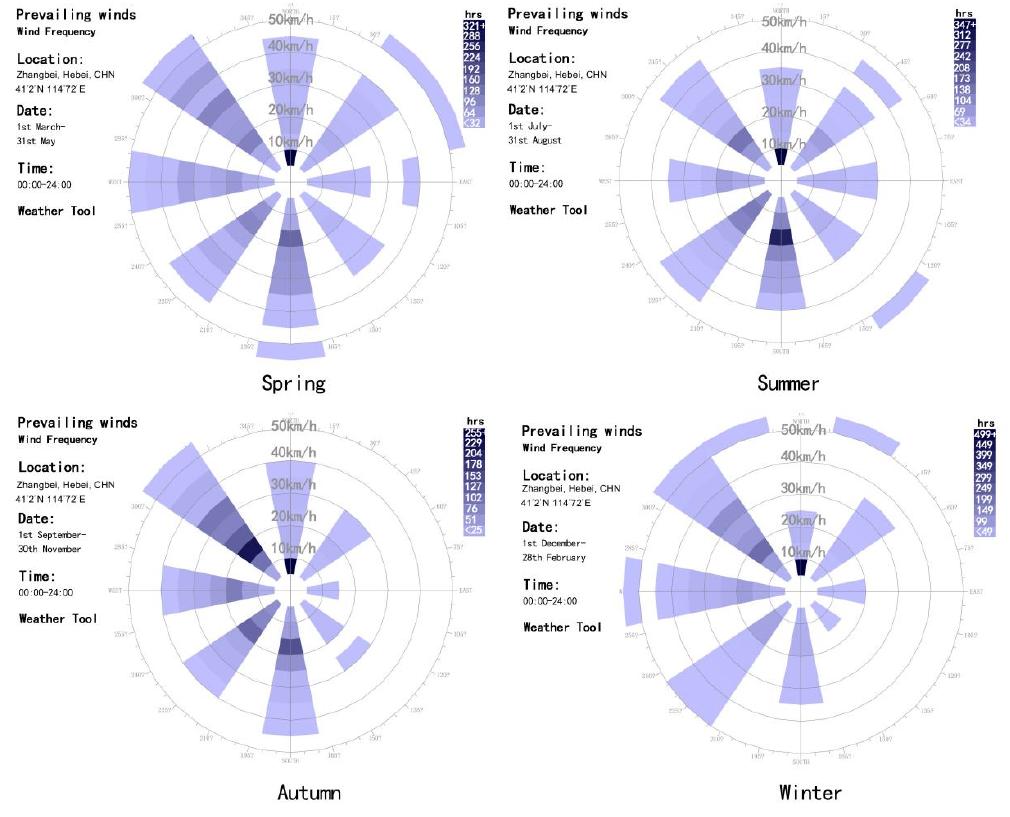
Figure 6. Wind roses in Zhangjiakou City.